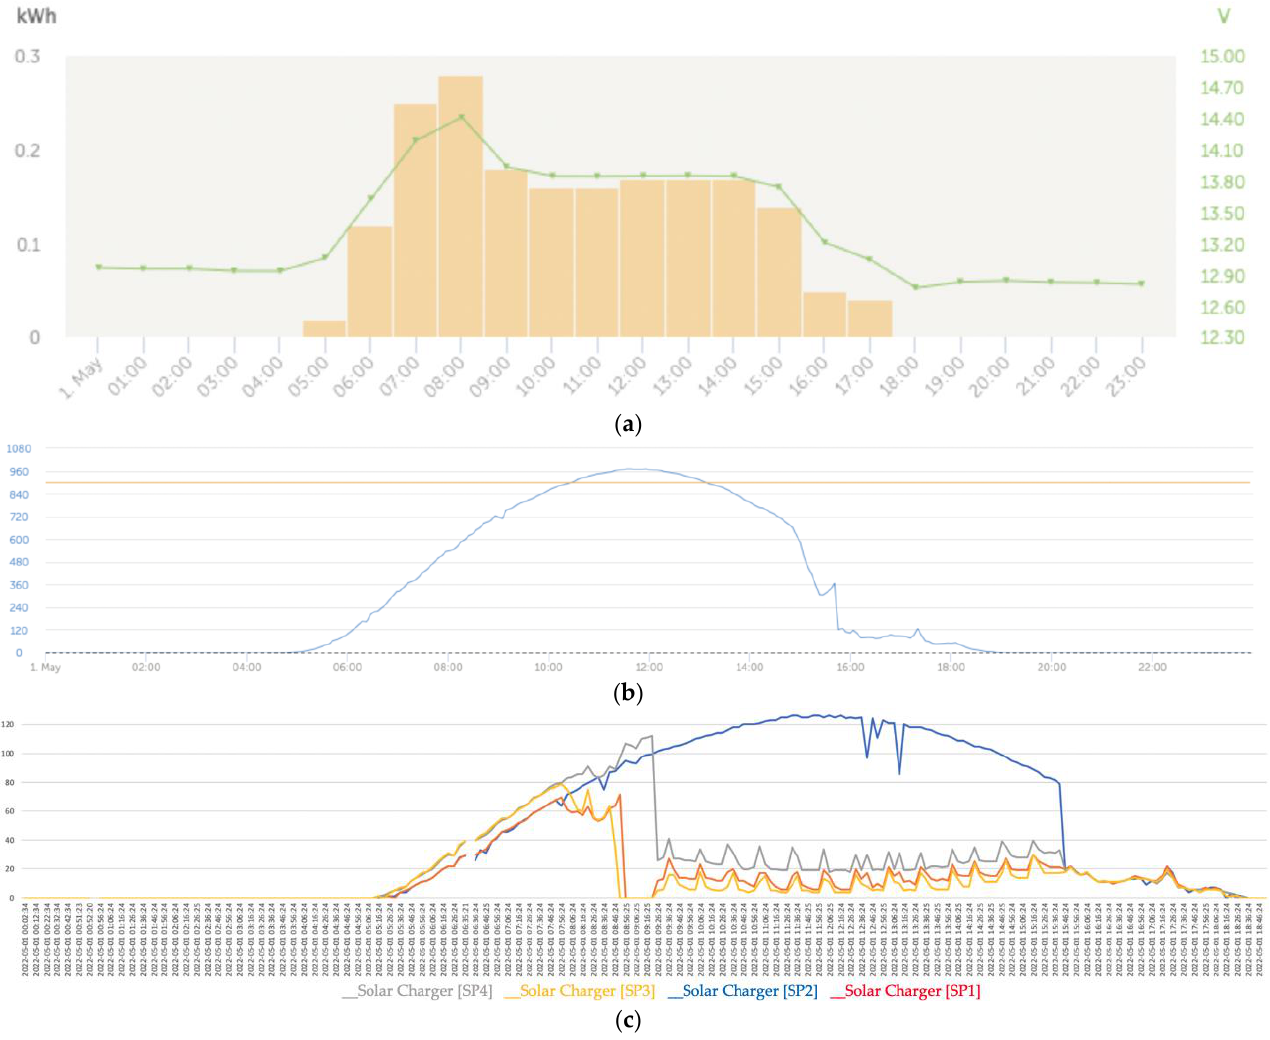
Figure 19. ( a ) Daily charge phases: initial, absorption, and flotation (1 May). ( b ) Solar irradiance (1 May). ( c ) Deviation trend comparative PV power data series analysis due to partial shading (1 May).